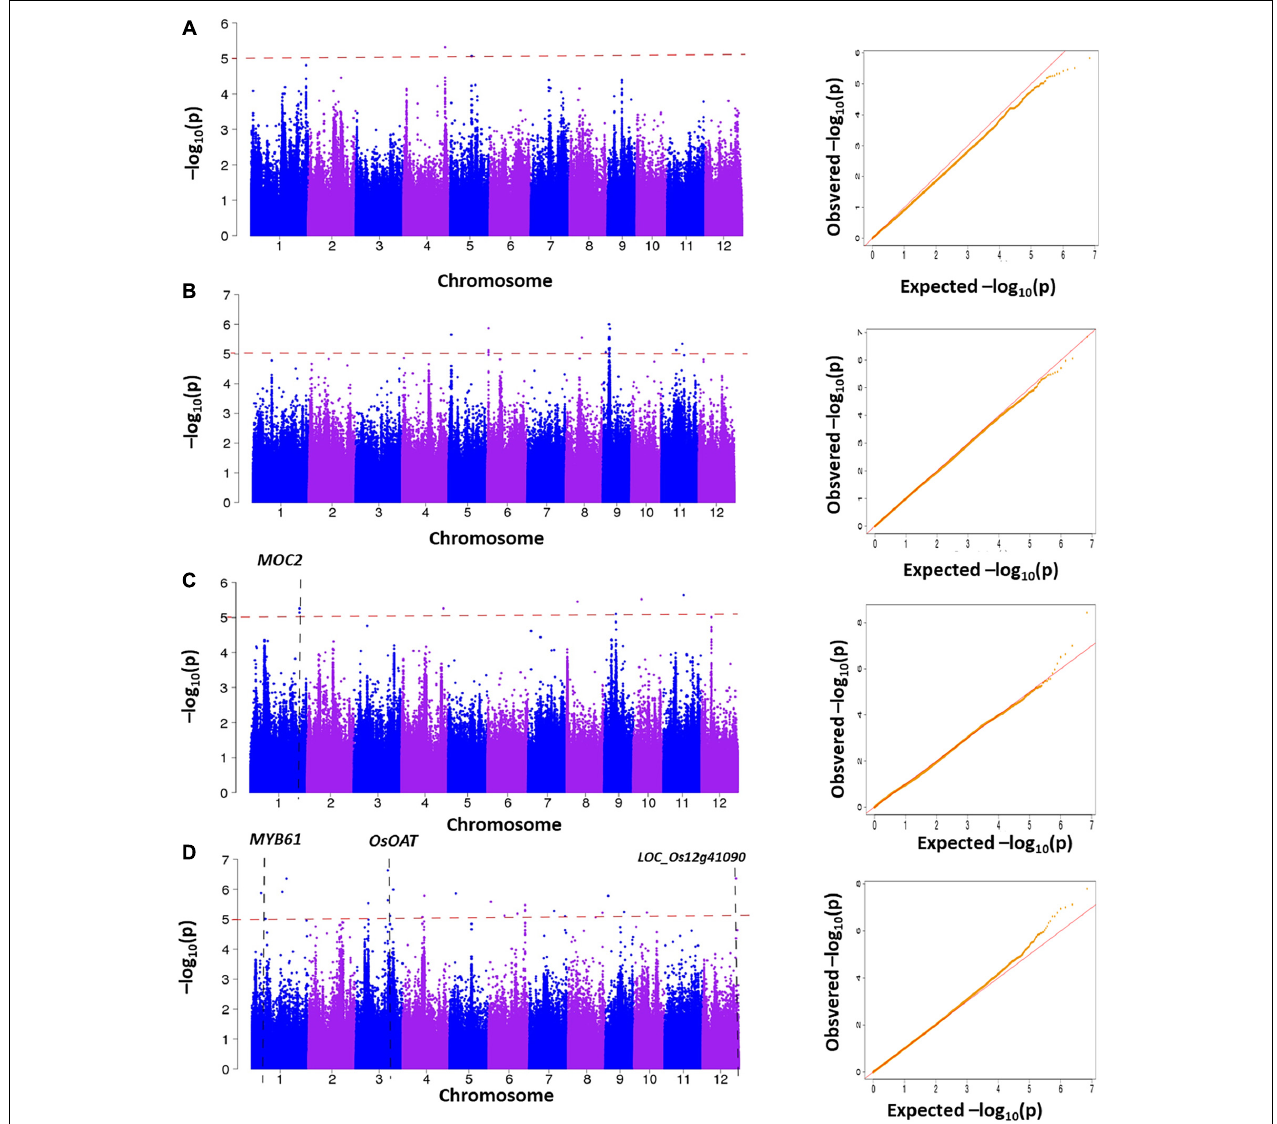
FIGURE 4 | Manhattan plots generated from the genome-wide association study (GWAS) analysis were derived from the trait differences ( (cid:77) NN-LN) of NUE-related agronomic traits. (A) (cid:77) SV, (B) (cid:77) LL, (C) (cid:77) PH, and (D) (cid:77)